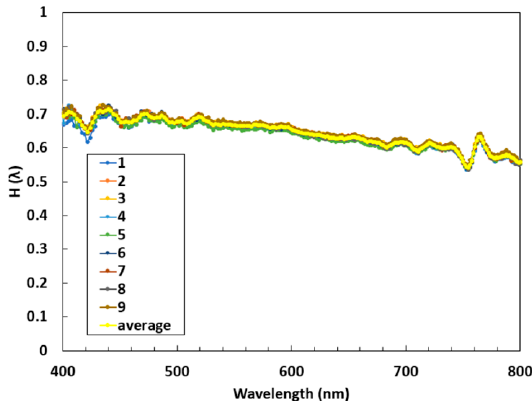
Figure 6. A transfer function to account for the differences in the two micro-spectrometers was calculated. Multiple measurements were taken over the same surface (right) and the average was applied to one spectrometer in order to “equal” the other.